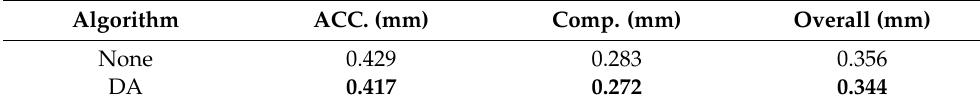
Table 3. Comparison of the impact of data augmentation on experimental results. Algorithm